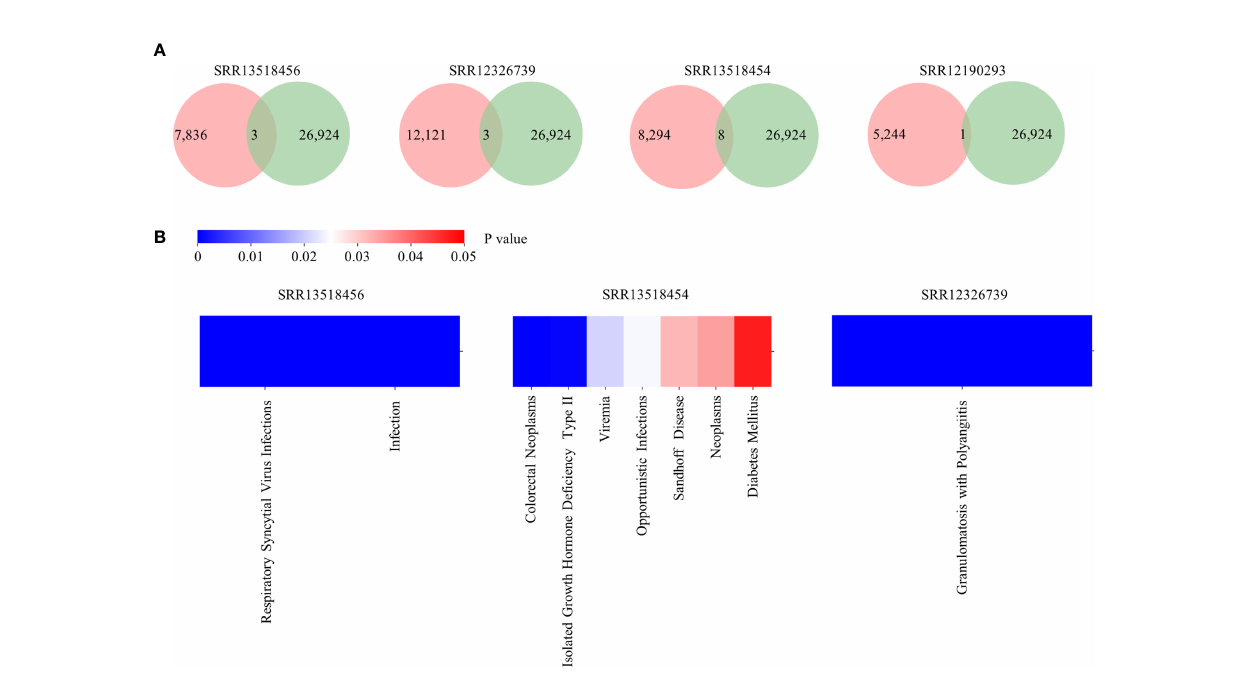
( Figure 2D ). The antibody query consists of three modules: “ Sequence query ” , “ Antigen/Disease query ” and “ Free text query ” .